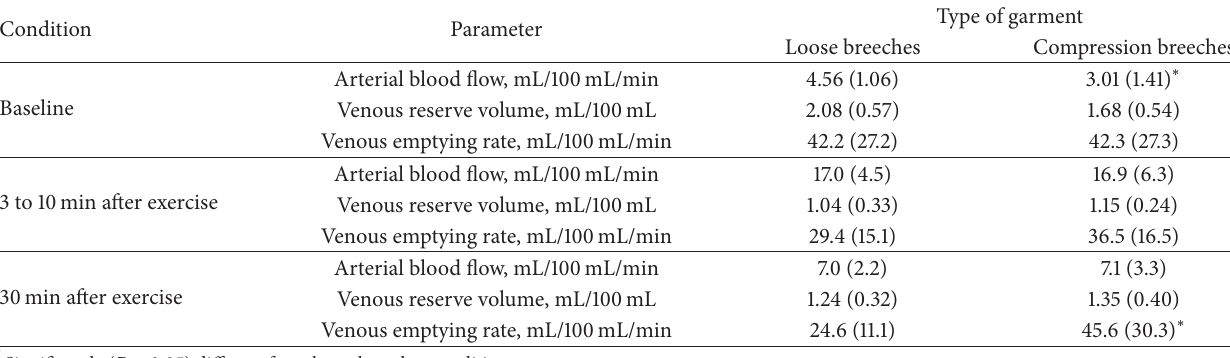
Table 4: Leg blood flow at baseline and after the running in two types of breeches.